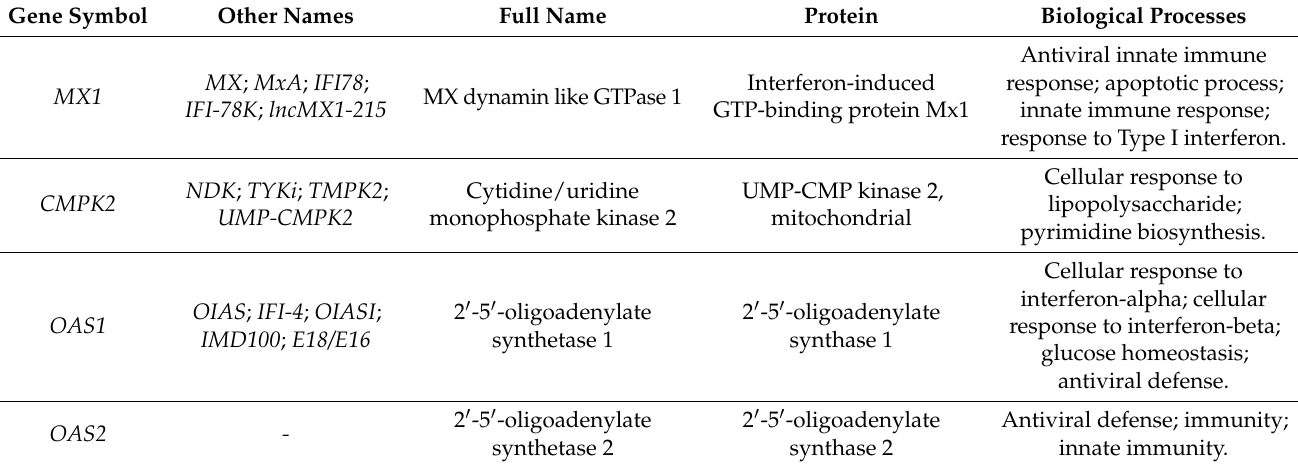
Table 4. Functional roles and general information of the down-regulated hub